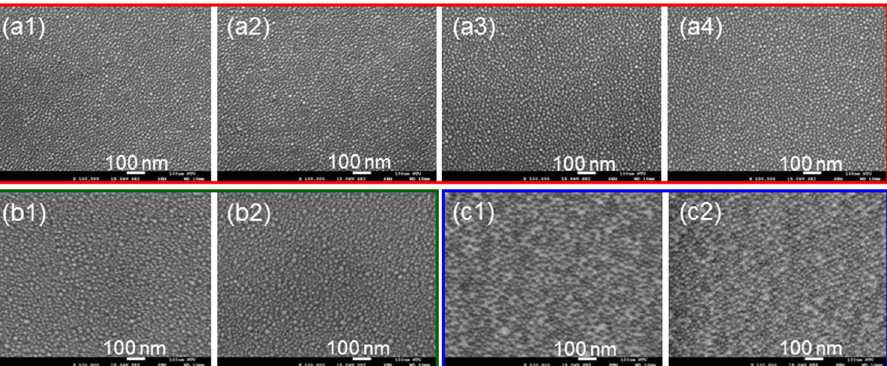
Figure 4. ( a1,a2 ) SEM image of a fresh Ag NP sample on GaN and its image after 40-hour illumination of the 395-nm LED, respectively, when the sample is placed in a vacuum chamber of 10 − 8 torr in pressure. ( a3 , a4 ) Results similar to part ( a2 ) when the sample is illuminated with ambient nitrogen and oxygen, respectively. ( b1,b2 ) SEM image of a fresh Ag NP sample on SiO 2 and its image after 40-hour illumination of the 395- nm LED in air, respectively. ( c1,c2 ) SEM image of a fresh sample on sapphire and its image after 40-hour illumination of the 395-nm LED in air,